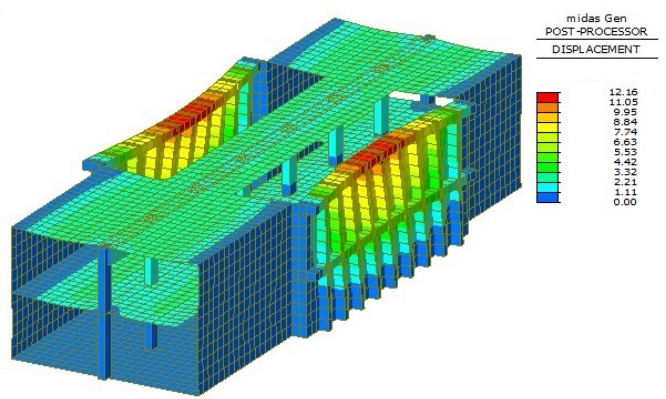
Figure 14. Three-dimensional global deformation (unit: mm).